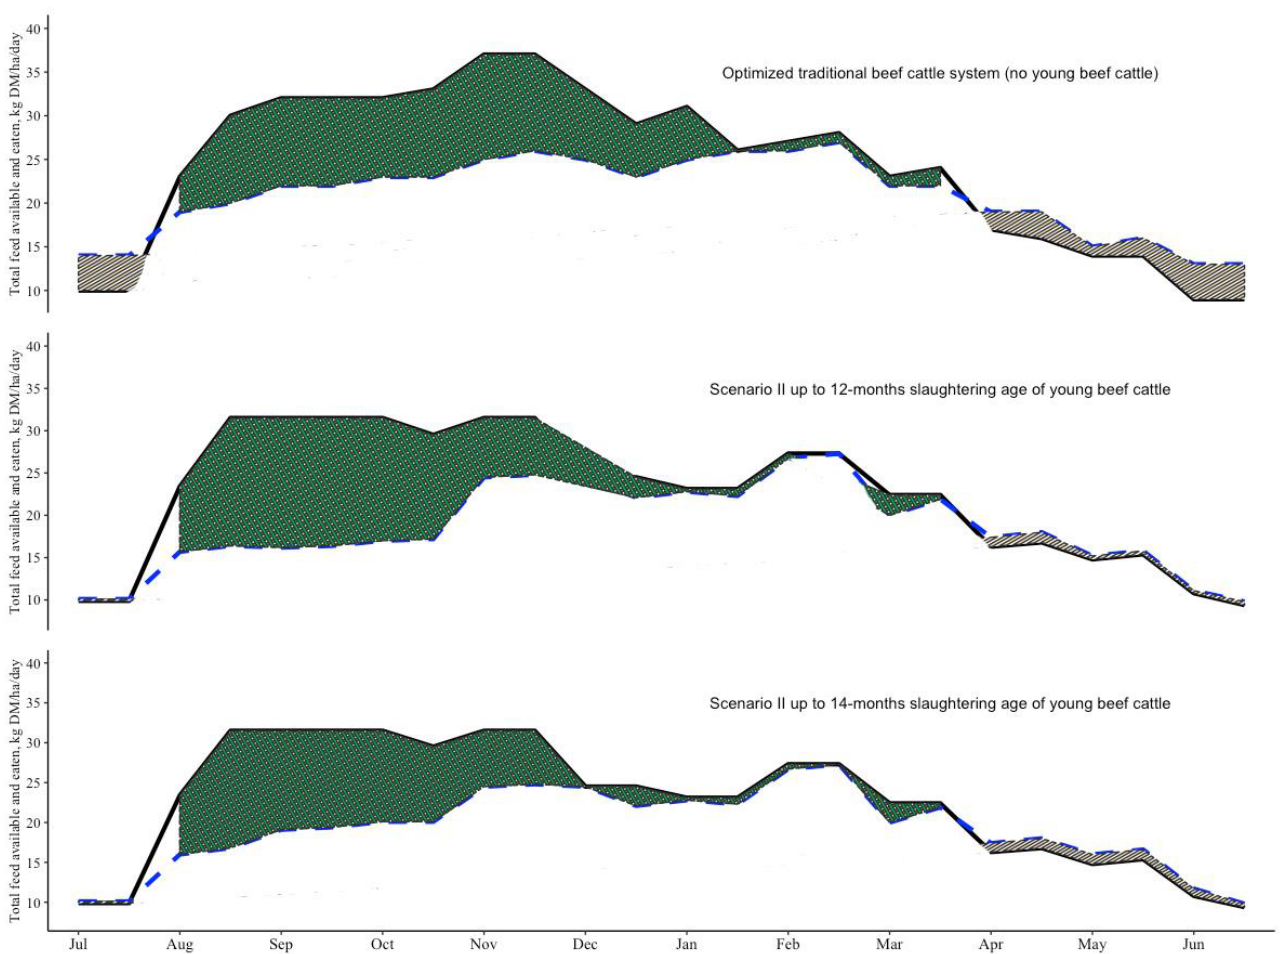
Figure 2. Utilizable pasture available (black line) and eaten by the beef cattle activity (blue dashed line which included silage) in the optimized system and Scenario II throughout the year. The excess available herbage (i.e., neither utilized nor processed for silage) is indicated by the green shaded area and the deficient of available herbage (i.e., where cattle requirements were greater than the available pasture) which was supplemented with silage is indicated by the striped area.